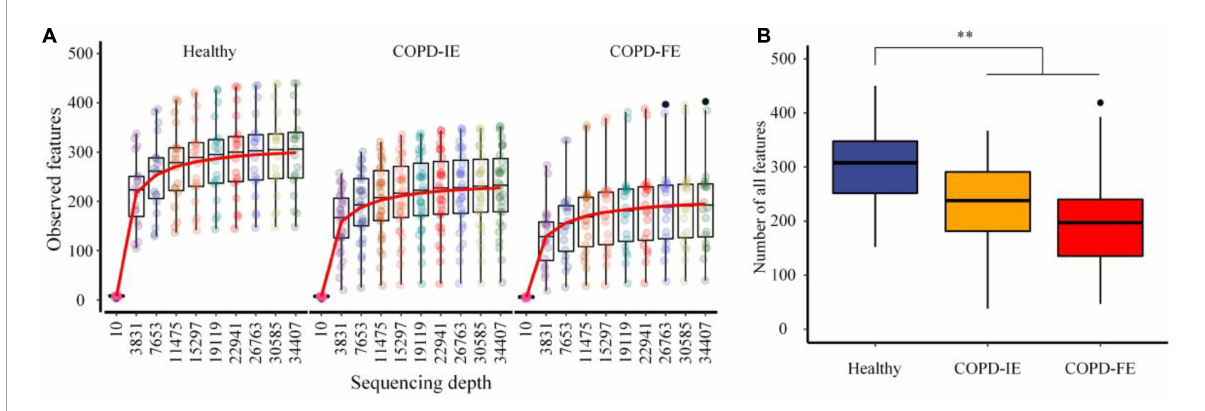
FIGURE2 The rarefaction analysis between the number of samples and the number of amplicon sequence variants (ASVs) features. (A) Sampling depth and ASVs features. (B) All observed ASVs features in different groups. COPD, Chronic obstructive pulmonary disease; COPD-IE, COPD with infrequent exacerbations; COPD-FE, COPD with frequent exacerbations. ∗∗ p < 0.01.